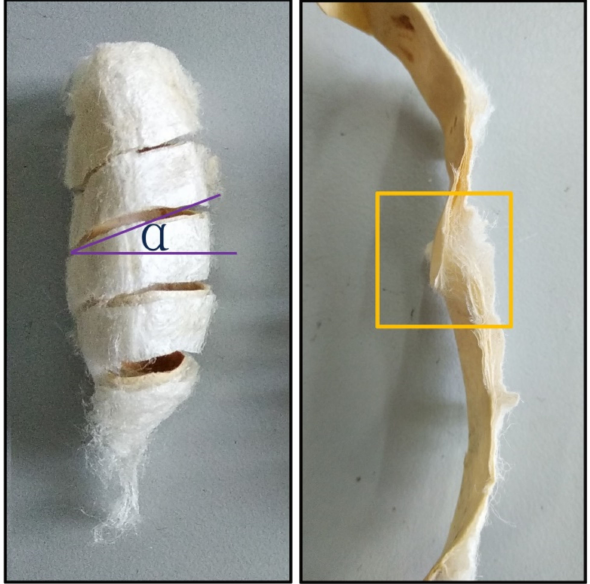
Figure 1. Schematic diagram of spiral sampling and digital images of fracture surfaces of cocoon shells after tensile failure. The yellow box shows the shape of the broken cocoon